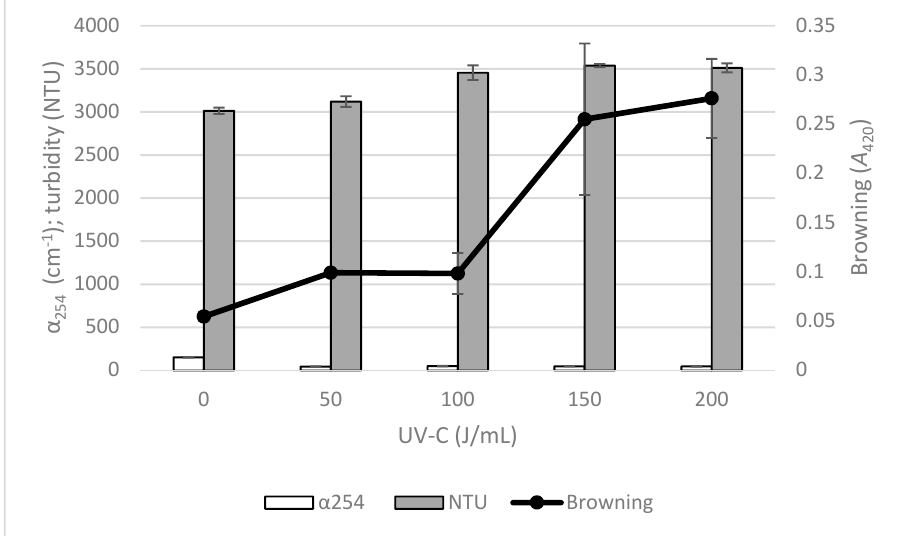
Figure 4. Physicochemical changes in apple juice with added ascorbic acid after UV-C treatments applied with recirculation at different doses (50, 100, 150, and 200 J/mL). α 254 (cm − 1 ) is represented by white bars, turbidity (NTU) is represented in grey bars, and browning (unitless) is represented by the plot line. Error bars mark the standard deviation between samples mean.